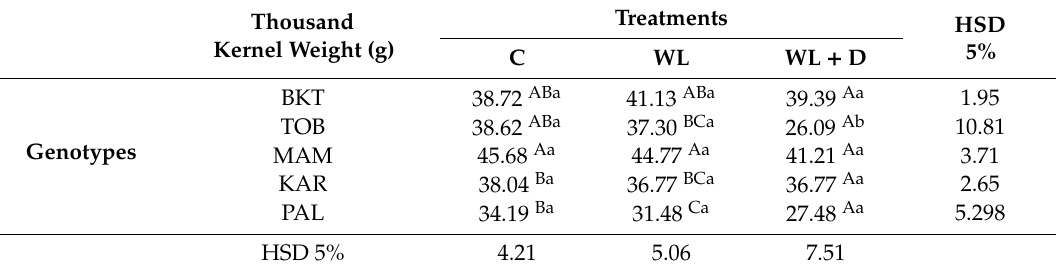
Table 2. Thousand kernel weights of ‘B á nk ú ti 1201’ (BKT), ‘Mv Toborz ó ’ (TOB), ‘Mv Mamb ó ’